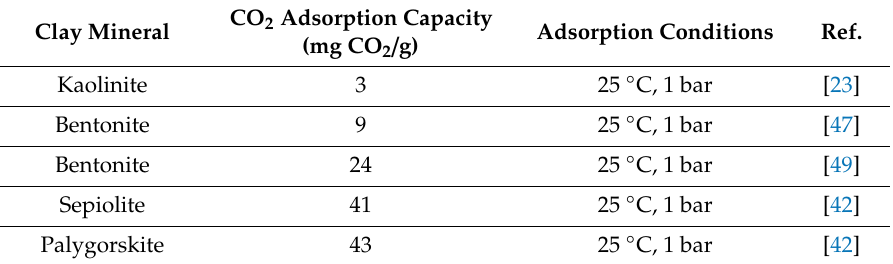
Table 2. CO 2 adsorption capacity of activated clay through acid treatments.